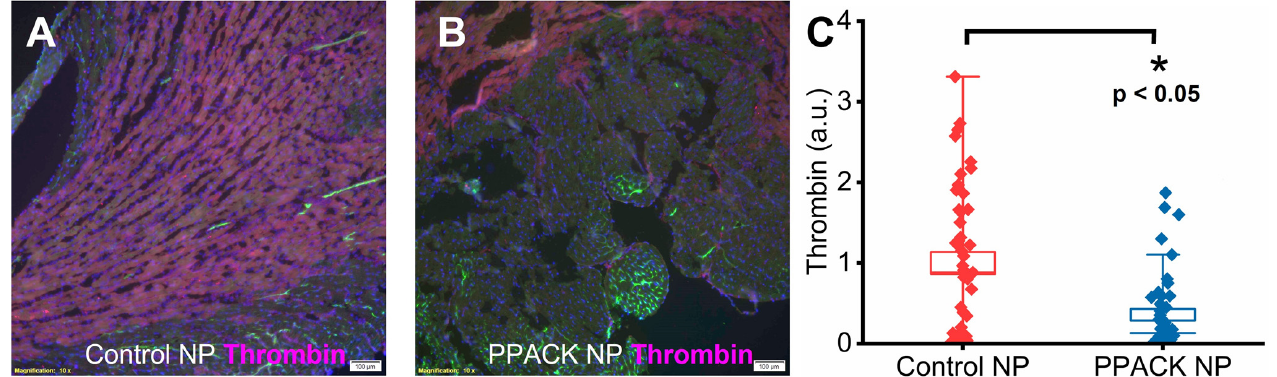
Figure 3. PPACK PFC NP treatment reduced thrombin deposition in border zones. Thrombin staining (red) in the heart from control NP-treated ( A ) and PPACK NP-treated ( B ) mice. Green fluorescence signal indicates blood vessels in the normal region of the heat. DAPI was used for nuclei staining (blue). The size of the scale bar was 100 µm, and the magnification was 10×. ( C ) Thrombin content in border zone regions of interest for the control NP or PPACK NP treatment. ( n = 3 mice per group n = 45 PPACK NP and n = 45 control NP regions of interest. Mean ± SEM; nonparametric analysis on n = 3; *: p < 0.05).